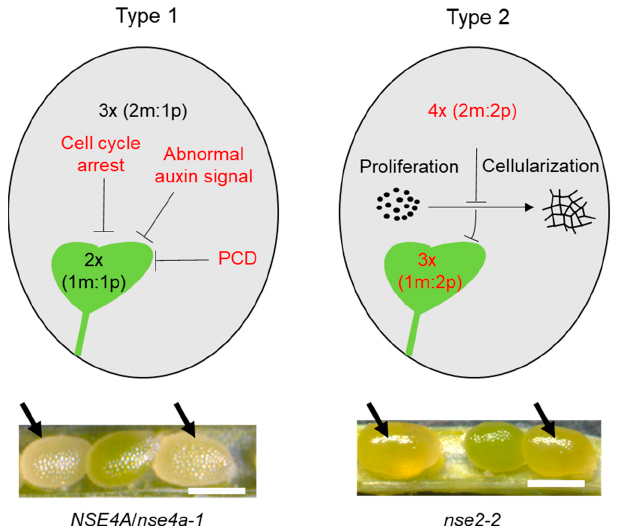
Figure 2. Two types of abnormal seed phenotypes were found in the SMC5/6 complex mutants. The ovals represent schematically drawn seeds with embryos in green and endosperm in gray. Mutant seed Type 1 has normal ploidy with diploid (2 × , 1m:1p) embryo and triploid (3 × , 2m:1p) endosperm, embryo aborts in early stages due to cell cycle arrest, abnormal auxin signal, and programmed cell death (PCD). The image below shows Arabidopsis seeds 13 days after pollination (DAP), with Type 1 seed indicated by the arrow. The mutant seed Type 2 has abnormal ploidy with triploid embryo (1m:2p) and tetraploid (4 × ) endosperm containing two maternal and two paternal genomes (2m:2p). An excess of paternal genome delays endosperm cellularization, inhibits embryo development, and frequently leads to seed abortion. Examples of Type 2 seeds are shown below and indicated by arrows. Type 2 seeds usually appear larger than average seeds, with a smooth surface. Bars = 500 µ m. Type 1 defective seeds correspond to the originally described EMBRYO DEFECTIVE (EMB) phenotype for SMC5 (EMB2782) and NSE1 (EMB1379). These abnormal seeds are